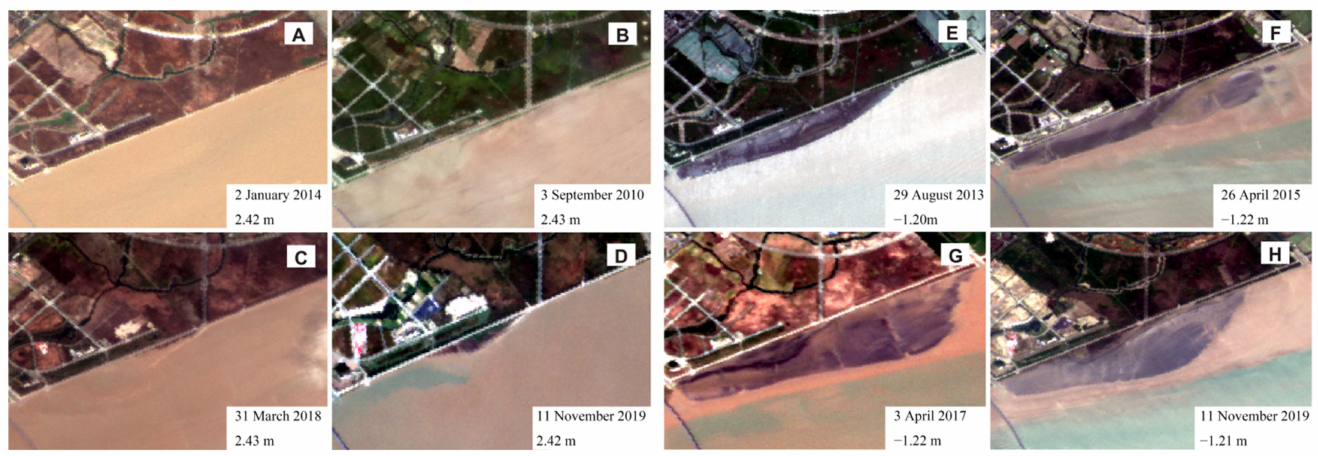
Figure 2. ( A ) A satellite image of the LGTF acquired on May 2021 from Google Earth and ( B , C ) aerial photos at low tide (the positions are shown in panel A ).